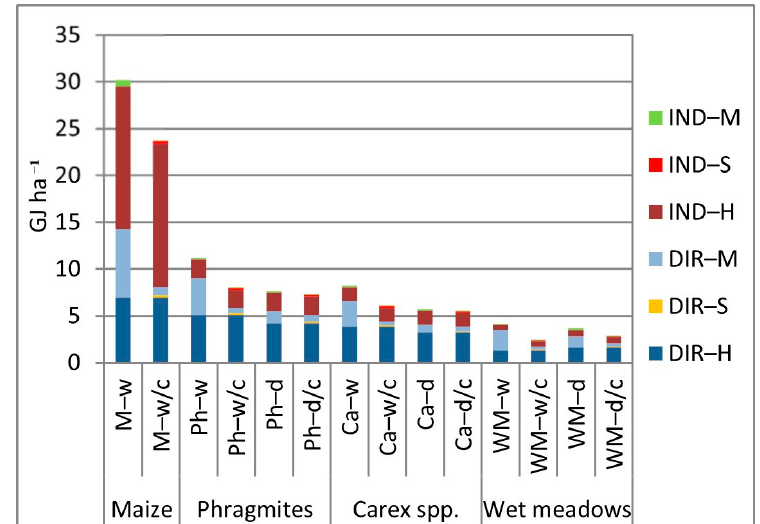
Figure 4. Energy consumption calculated for all steps of energy production from biomass; w—wet fermentation, d—dry fermentation, c—separation and composting of digestate; DIR—direct energy input from fuel, IND—indirect energy input; H—cultivation and harvest, S—separation of digestate and composting of solid phase, M—management of digestate/compost.